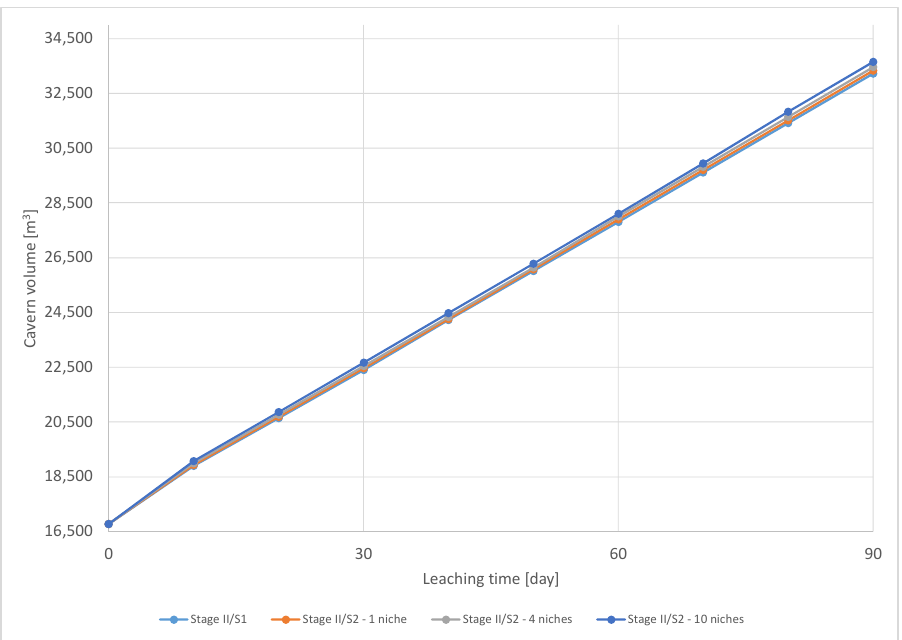
Figure 17. Comparison of the change in cavern volume for Phase I of Stage II for different scenarios.